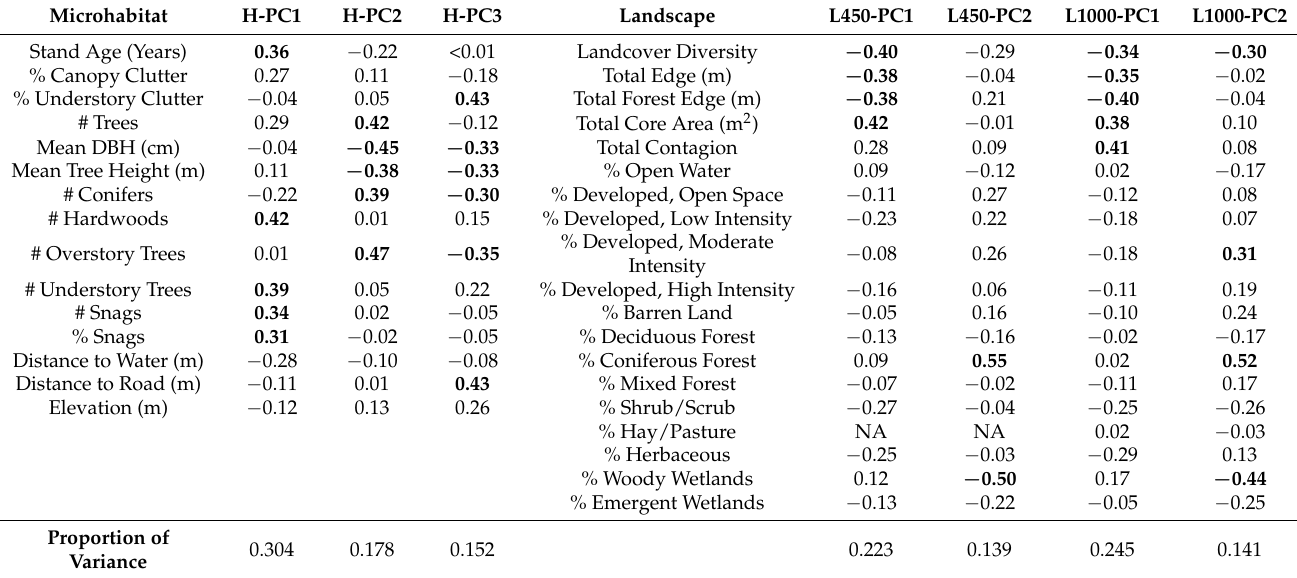
Table 1. Principal components of microhabitat and landscape variables measured from 450 m (L450) and 1000 m (L1000) buffers. Only those PC’s that exceeded expectations from the broken stick stopping rule are included. Variable loadings ≥ 0.3, highlighted in bold, are considered explanatory variables of each principal component.